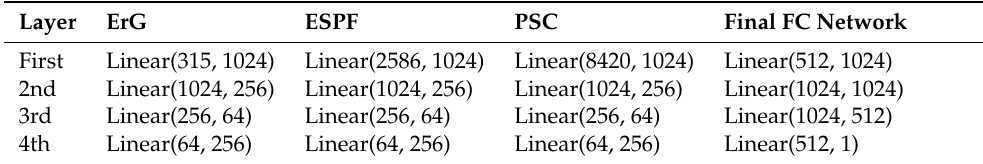
Figure 1. Framework of the proposed method to predict DTI. The in silico component starts with preprocessing and data construction. Each data construction includes the entire positive set and bagging on the negative set. These base learners are then aggregated and create the deep ensemble- balanced learning models. The output is the predicted probability of unknown interaction of a drug-target pair. The architecture of each individual learner is shown as a part of this framework, where the drug and protein representations are first extracted by utilizing neural networks from their corresponding SMILES and amino acid sequences, and then these encodings are concatenated and fed into the final neural network, where the model is trained. The in vitro component includes the validation part of our framework, where computational results of our proposed model are compared to the experimentally-measured DTI in the laboratory. Table 3. Details of the neural